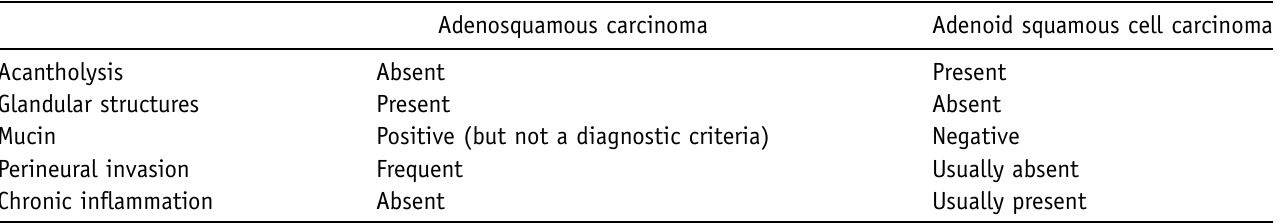
Table II. Histopathological comparison of ASC and ASCC.